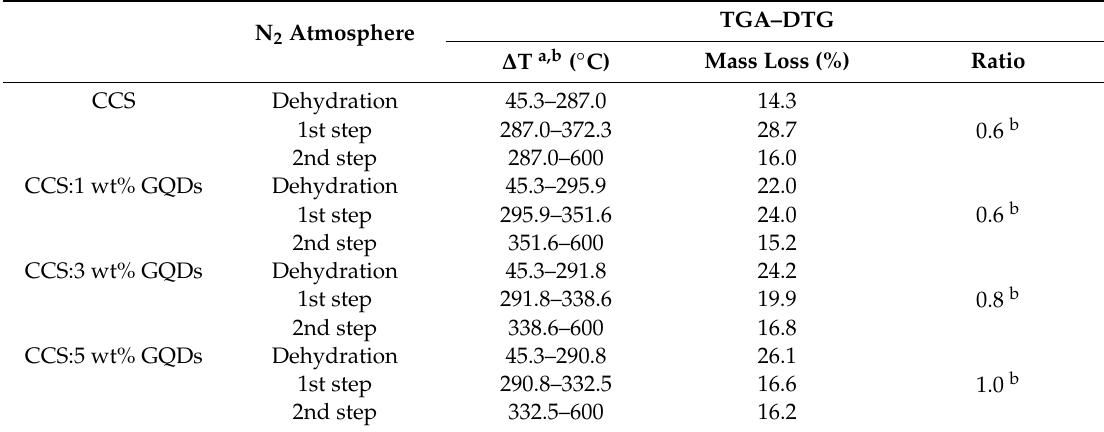
Figure 2. ( a ) TGA, ( b ) DTG and ( c ) FTIR spectra of pure CCS, and CCS:GQDs nanocomposites. Table 1. Data obtained from TGA–DTG curves of CCS and its Table 1. Data obtained from TGA–DTG curves of CCS and its nanocomposites.